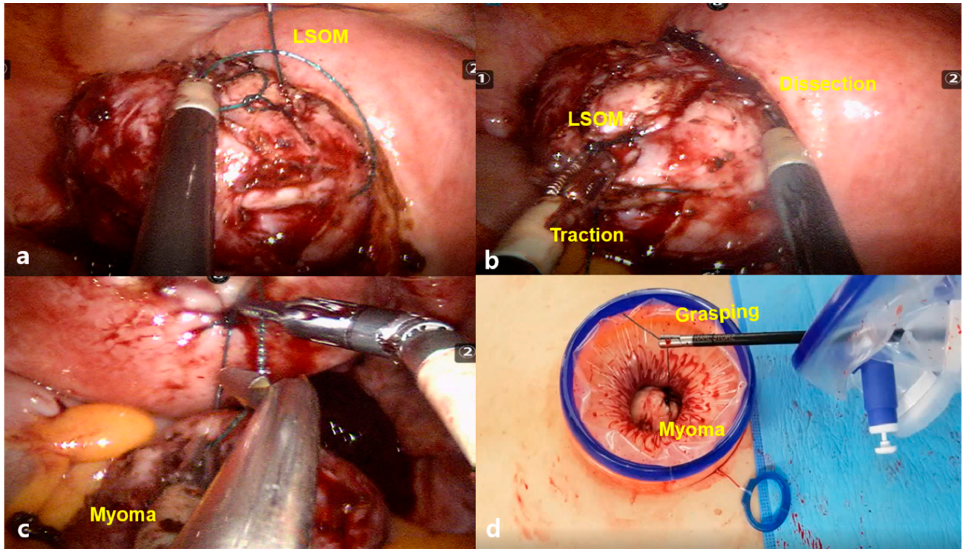
Figure 2. The locking suture on myoma (LSOM) technique in single-site robotic myomectomy. ( a ) Traction of myoma is performed by grasping the thread with a semirigid fenestrated bipolar forceps, and the next suture for the LSOM technique is applied. ( b ) During the myoma enucleation process, the traction of myoma becomes easy by grasping the thread with a semirigid fenestrated bipolar forceps ( c ). ( d ) The retrieved myoma can be easily removed by simply grasping the thread with any instruments, such as robotic wristed needle holder, laparoscopic needle holder, or atraumatic forceps.